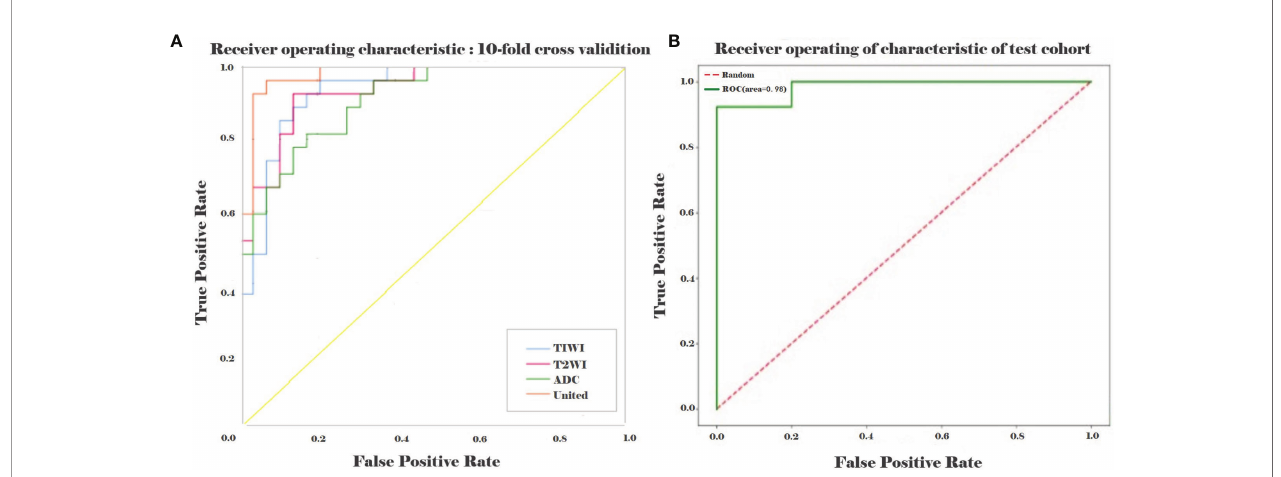
FIGURE 5 | ROC curve analysis of the primary set (A) and test set (B) between the stage III type 2 DN and normal subjects. The solid lines in different colors indicate that the ROC curve for each model correspond to a different AUC, which represents the positive rate of predict and distinguish the stage III type 2 DN and normal subjects. The solid lines in different colors indicate the ROC curves of the T1WI, FS-T2WI, ADC and united